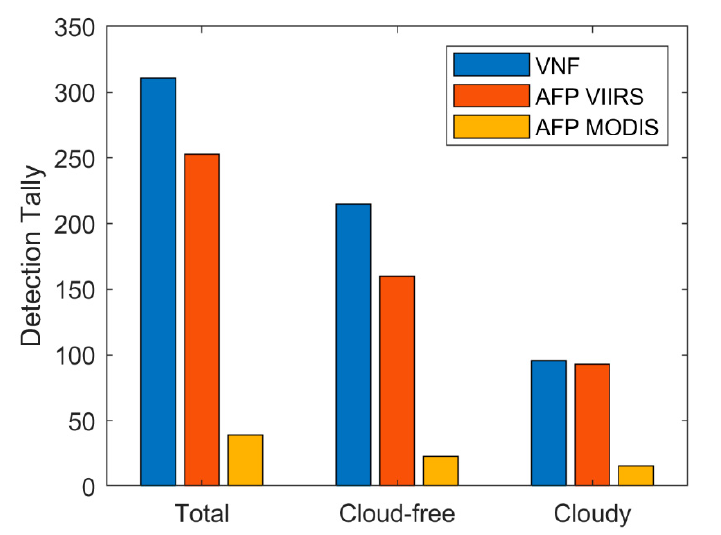
Figure 15. Comparison of VNF and AFP detection probability of gas flares.